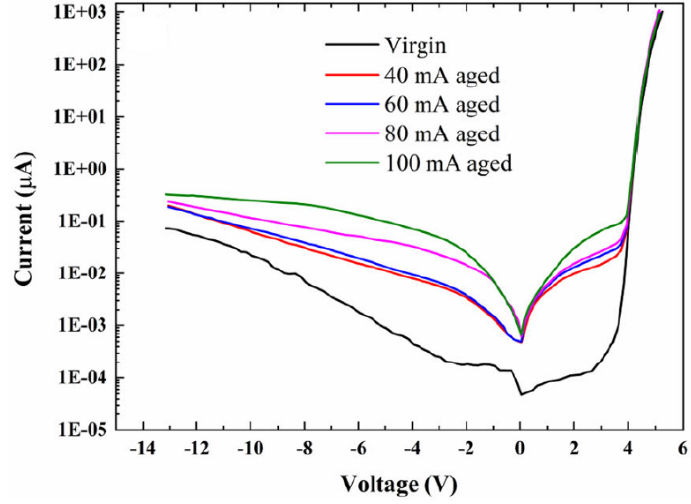
Figure 26. The I–V characteristics of the LEDs stressed at different currents. Reproduced with permission. [72] Copyright 2021, Springer.